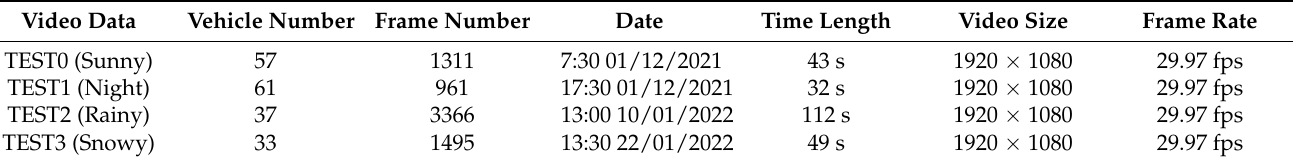
Table 6. Details of the four test video clips in the collected MWUAV